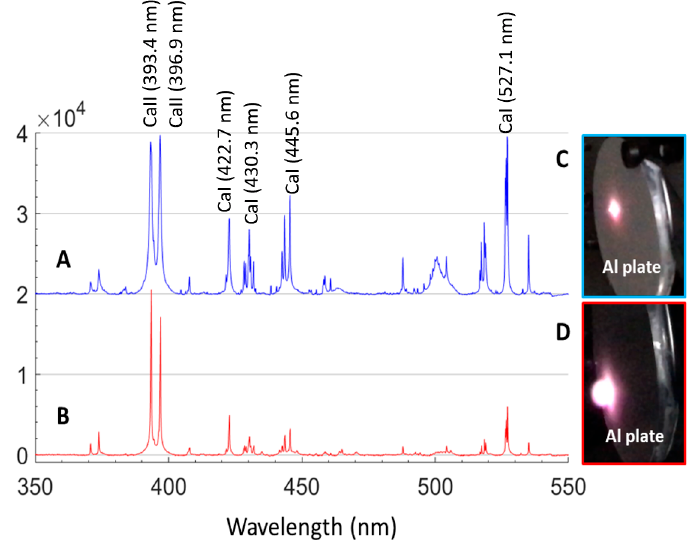
Figure 6. Laser-induced breakdown spectroscopy (LIBS) spectra of gypsum under Earth ambient conditions ( A ) and simulated Mars conditions (700 Pa, CO 2 gas) ( B ); photographs of plasma excited on an aluminum plate under Earth ambient conditions ( C ) and simulated Mars conditions (700 Pa, CO 2 gas) ( D ).